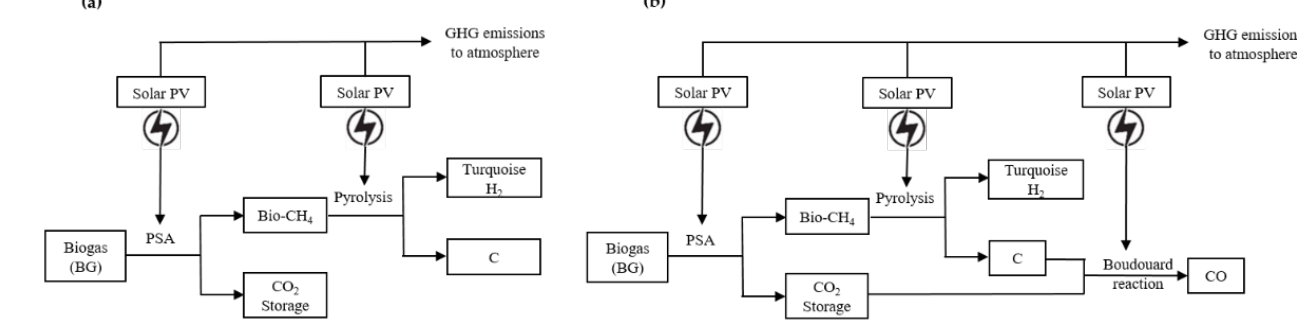
Figure 5. PFD of ( a ) turquoise hydrogen (BG-RE) and ( b ) turquoise hydrogen (BG-RE) with Boudouard reaction.